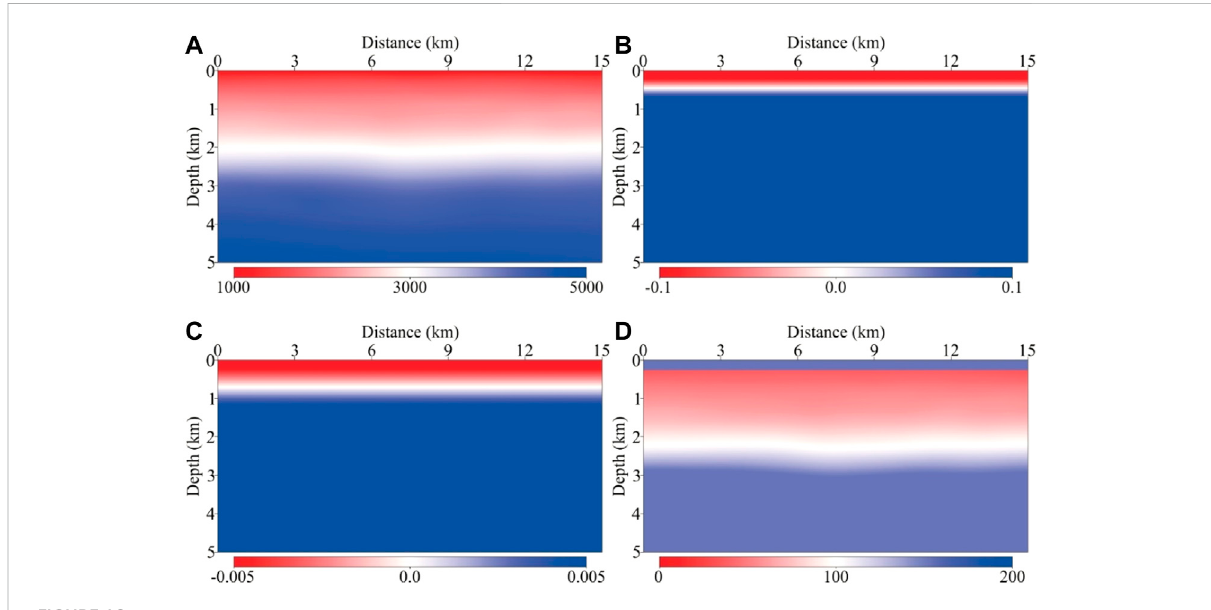
Migration models of the fi eld data. (A) Velocity model, (B) ϵ model, (C) δ model, and (D) Q